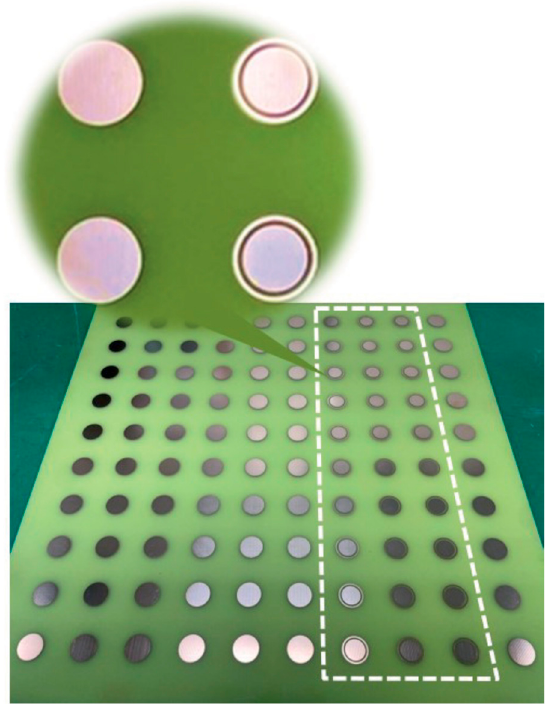
Figure 4. Fabricated 10 × 10 RIS.